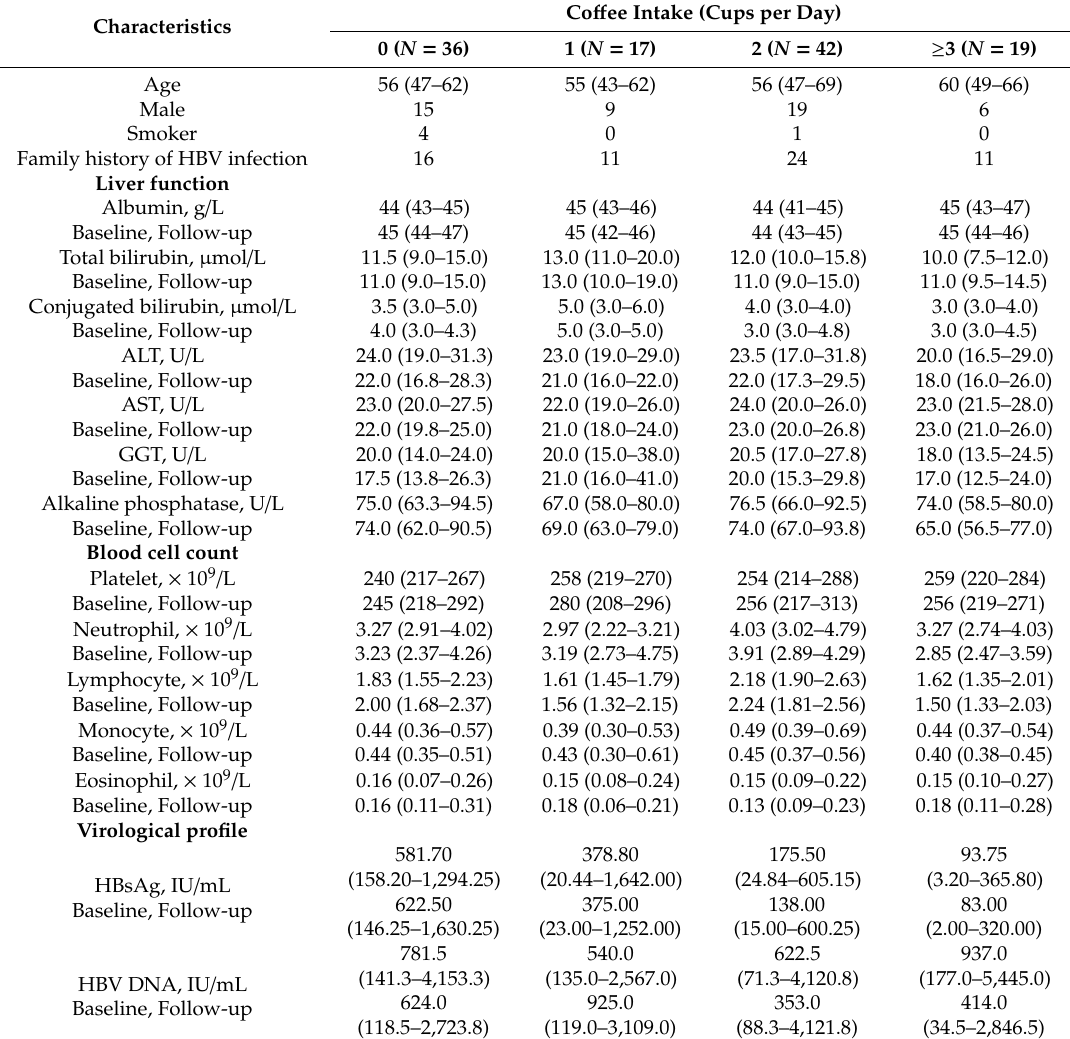
Table 4. Demography, clinical and virological characteristics of co ff ee